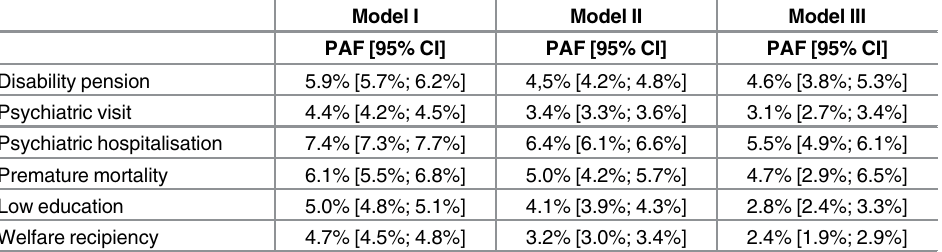
Table 4. Population-attributable fractions, expressed as percentages, for TBI before age 25 y on poor functioning in